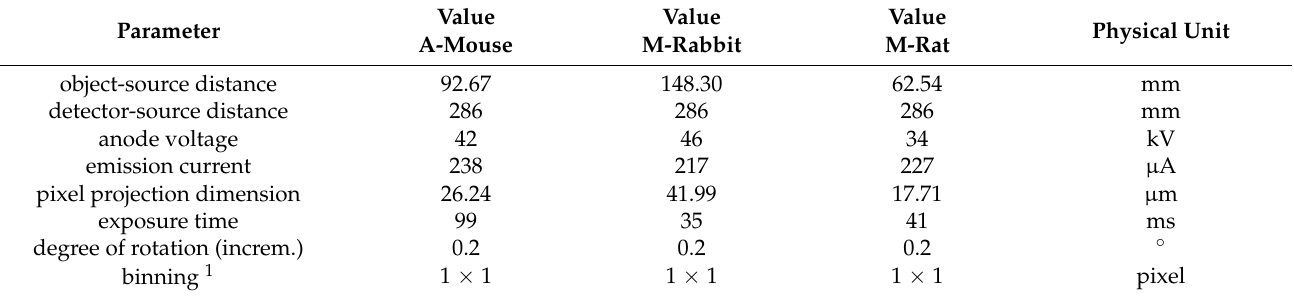
Table A17. Values of set parameters on SkyScan